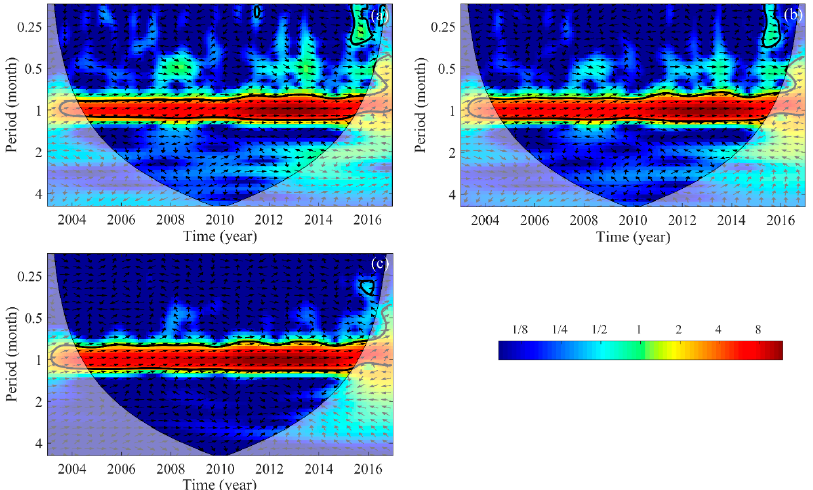
Figure 10. Cross-wavelet transforms between GWSA and climatic factors at monthly scale in the HC. ( a ) Precipitation; ( b ) evapotranspiration; ( c ) temperature. Under the background of climate change, precipitation is the input of water, and evapotranspiration is the output of water in a region. Therefore, precipitation minus evapotranspiration (P − ET) can represent the net recharge of surface water and groundwater [71]. During 2003–2016, the maximum P − ET occurred in June-September, and the minimum in January-April and October-December (shown in Figure 11). P − ET shows a significant downward trend relative to other time periods during 2007–2016, resulting in a significant decrease in net recharge. Such shortage of precipitation will directly hinder the growth of vegetation and human production, and excessive evapotranspiration will further accelerate the loss of available water resources and disrupt the balance of the water cycle [72]. Although the net recharge in summer is positive during